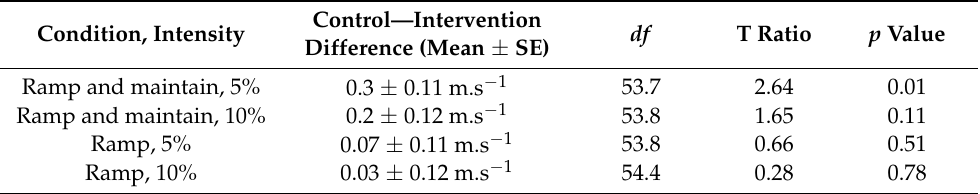
Table 2. Estimated Group differences in the conduction velocity (CV) across groups. Condition, Intensity